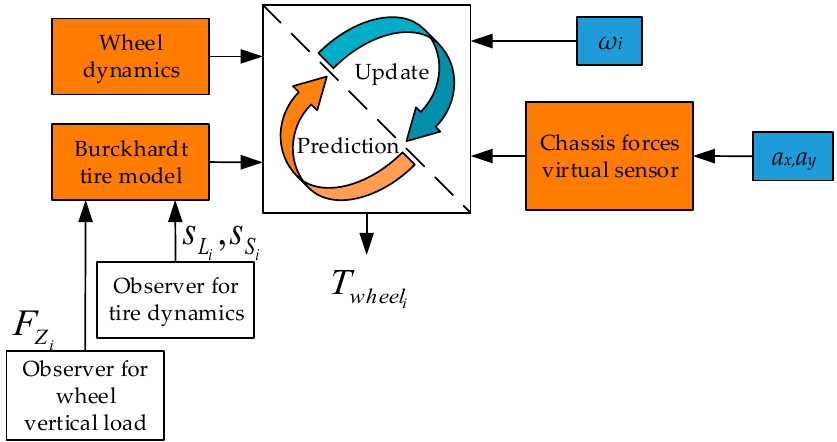
Figure 10. Structure of the proposed KF: the update part is based on the measurements coming from the hub sensors and the accelerometers; the prediction part relies on the wheels’ dynamics equations and on the tire model, which, in turn, requires the tire slip ratios and the vertical load.